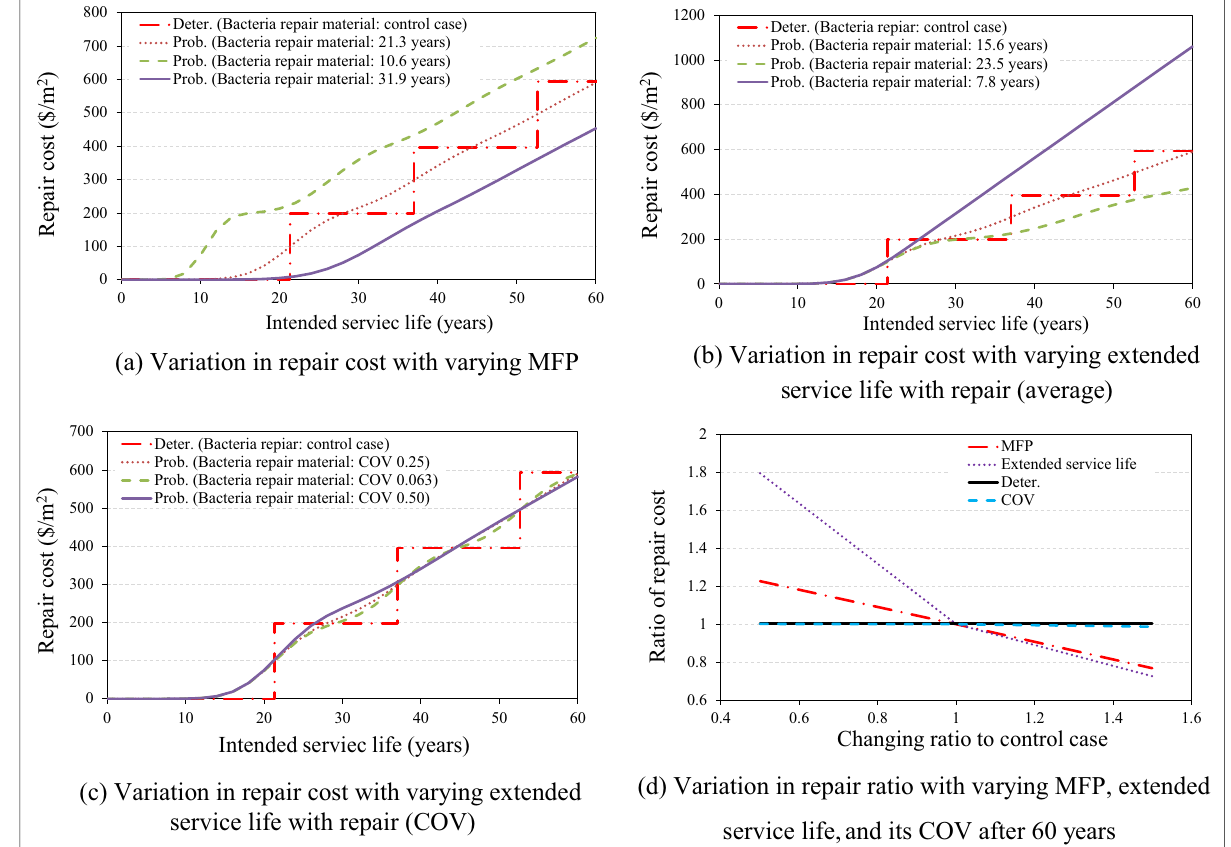
Fig. 6 Repair cost analysis considering changing MFP, extended service life, and